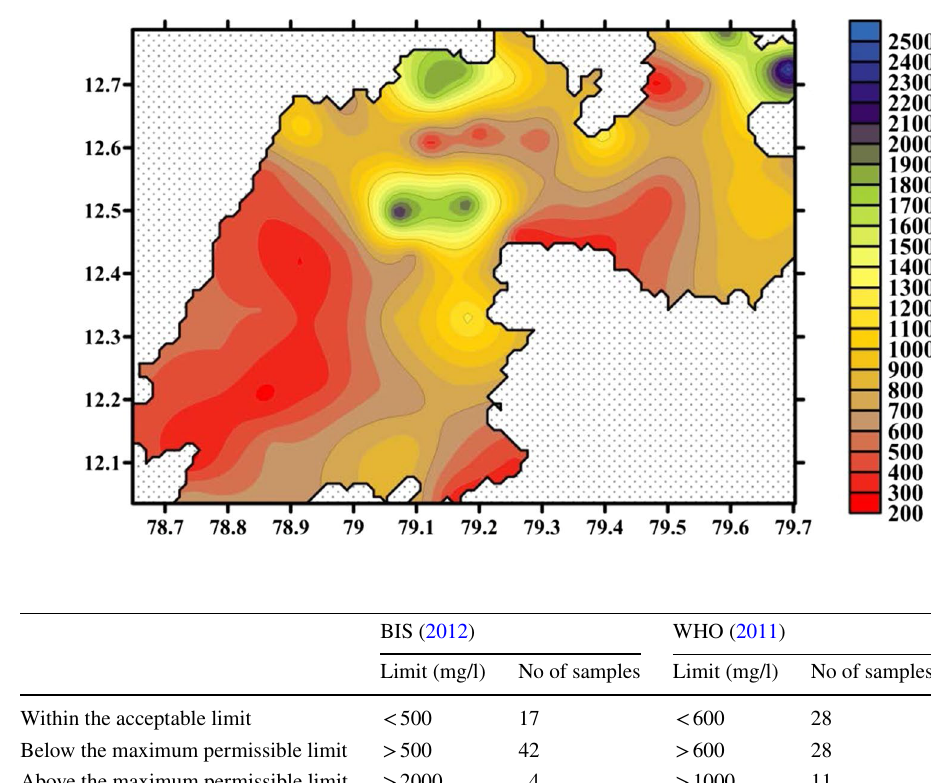
Fig. 10 Spatial variation of TDS in the study